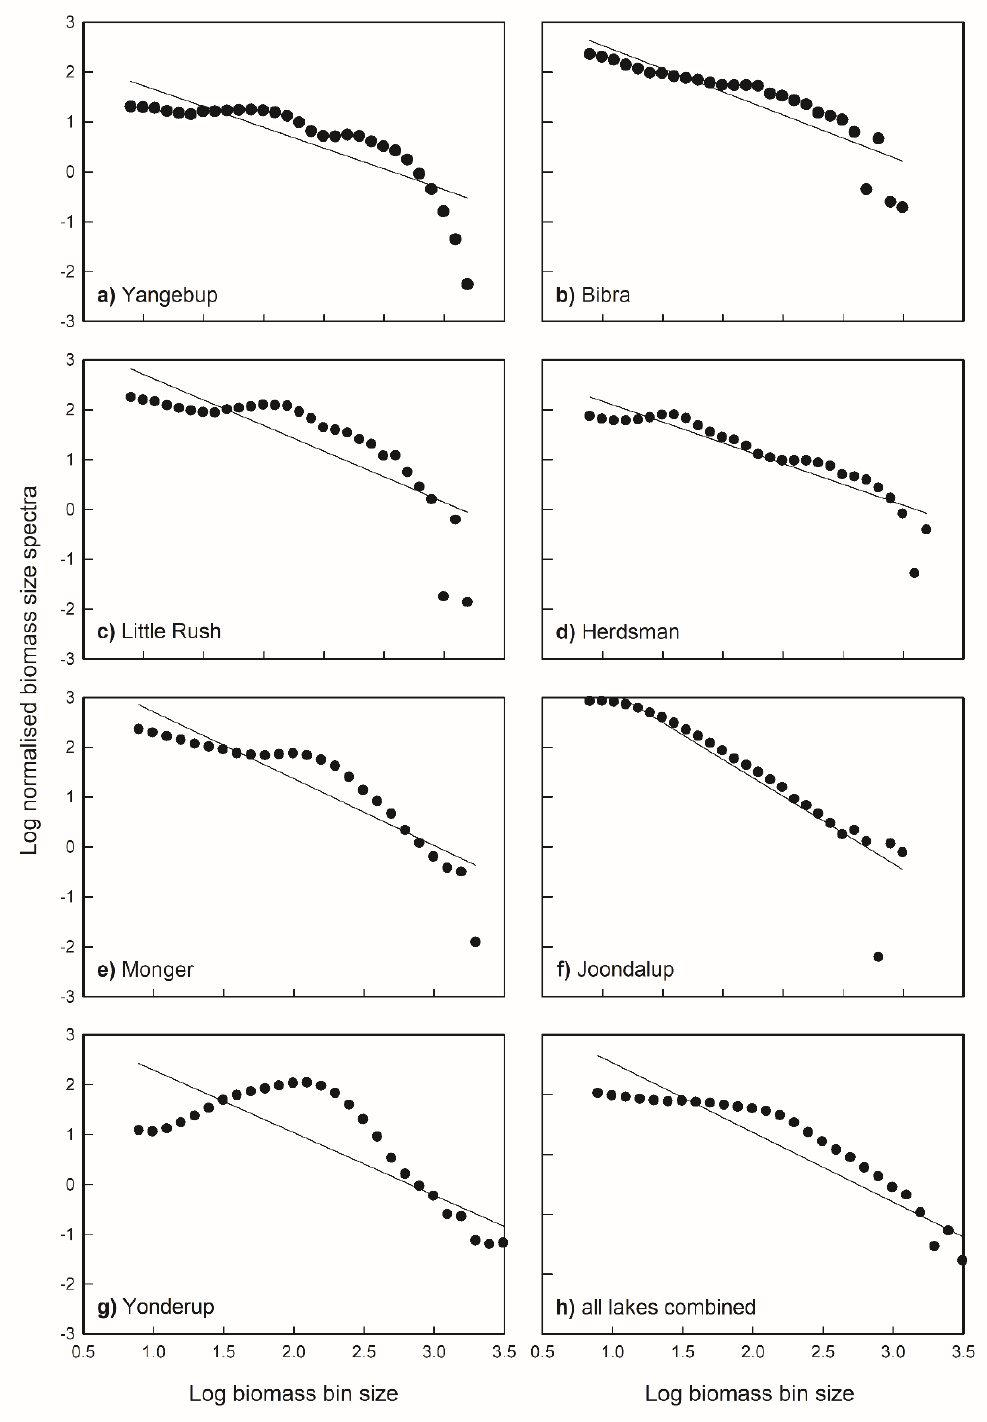
Figure 7. Mean normalised biomass size spectra (NBSS) of seven lakes: ( a ) Yangebup, ( b ) Bibra, ( c ) Little Rush, ( d ) Herdsman, ( e ) Monger, ( f ) Joondalup, ( g ) Yonderup, and ( h ) all lakes combined in one analysis. The NBSS was determined based on biomass data in 15 µ m equivalent spherical diameter (ESD) bin size intervals, as derived by the Laser Optical Plankton Counter, for size fractions between 300 and 2500 µ m